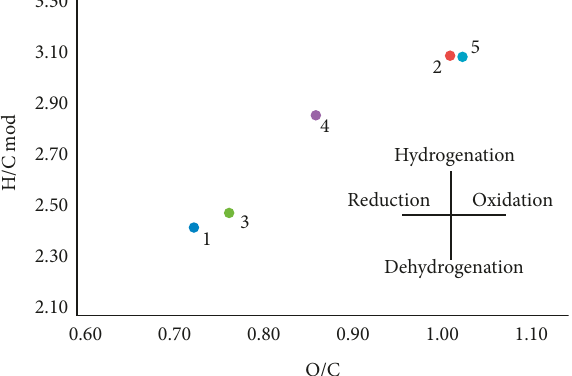
Figure 2: Elemental ratios of the studied HAs isolated from the study